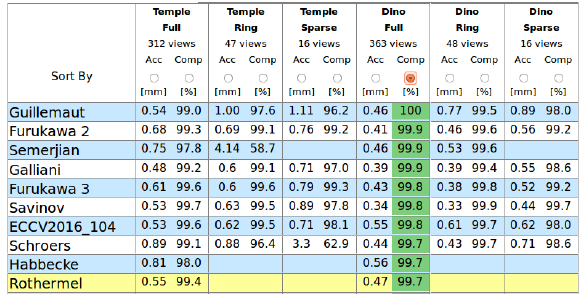
Figure 7: Results for the Middlebury benchmark using the dino dataset.